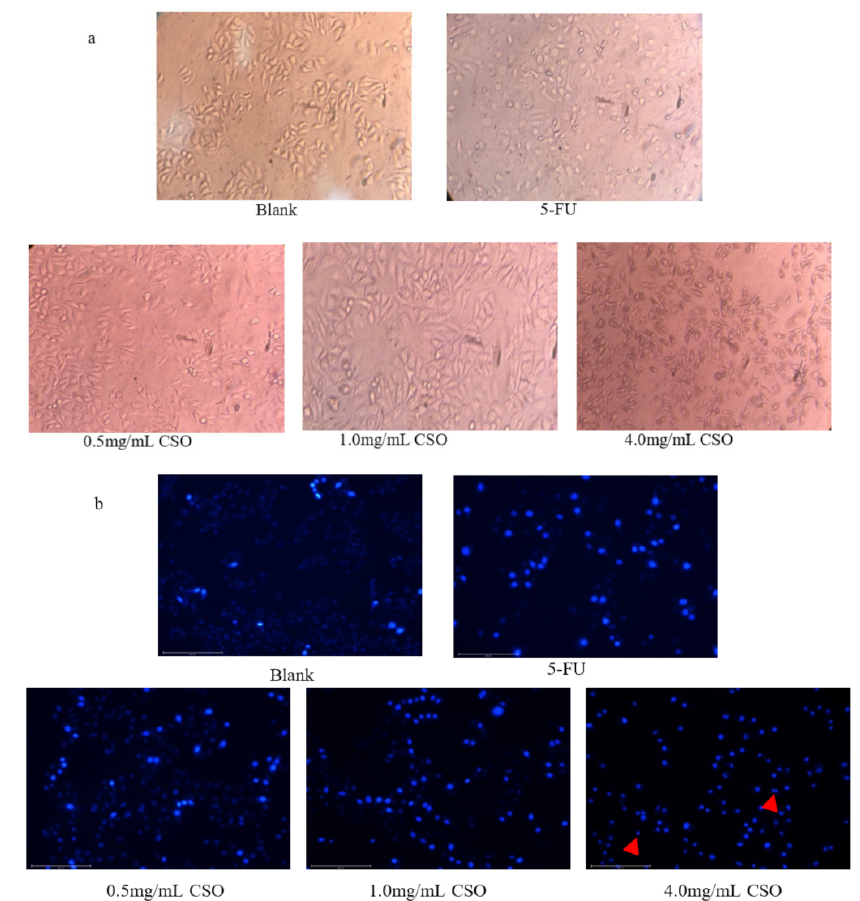
Figure 3. ( a ) Cell morphology was observed by inverted light microscopy ( ⊆ 40) after HT-29 cells were treated with CSO (0.5, 2.0, and 4 mg/mL) for 24 h. ( b ) CSO-induced apoptosis in HT-29 cells using Hoechst 33258 staining by fluorescent microscope ( ⊆ 200) after cells were treated with CSO (0.5, 2.0, and 4 mg/mL) for 24 h. Abbreviations: 5-FU, 5-fluorouracil; CSO, coix seed oil; apoptotic bodies are indicated by red